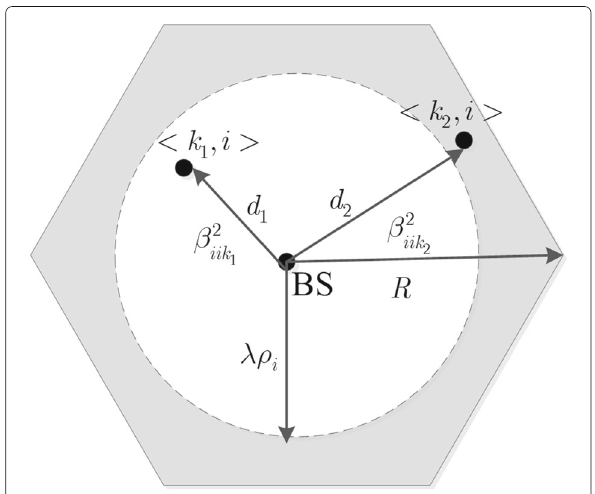
Fig. 2 The grouping parameter illustration of pilot scheduling scheme based on user grouping